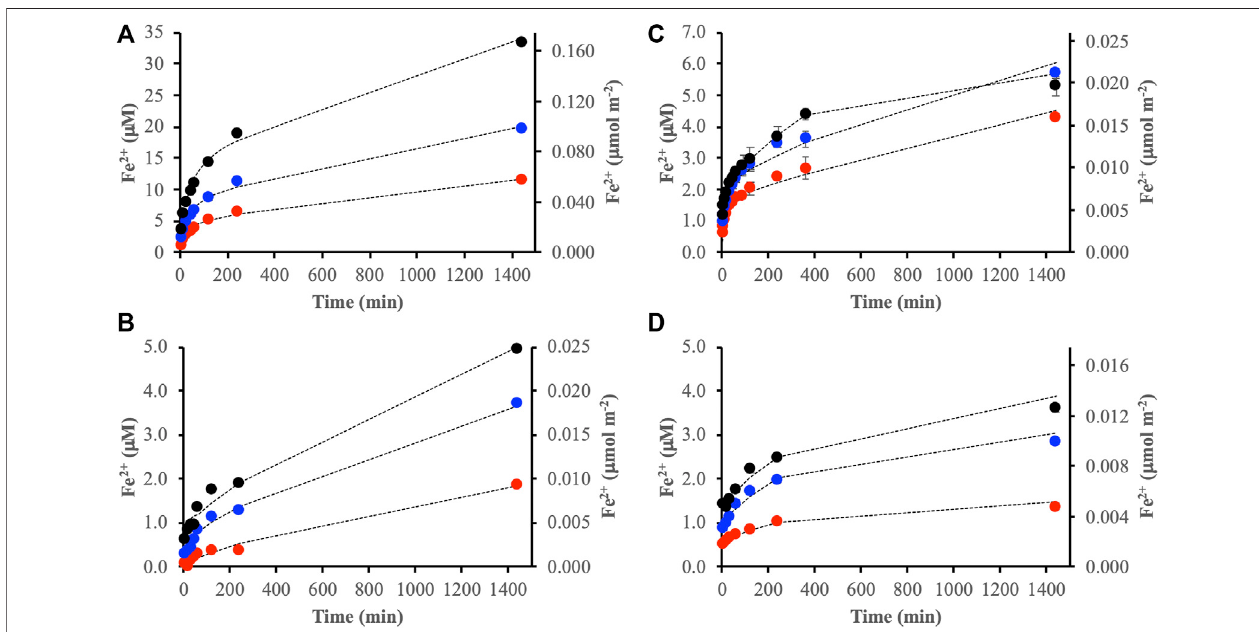
FIGURE 2 | Fe 2+ concentrations in solution from reductive dissolution by DOM mod-EtOAc of ferrihydrite (A) and goethite (C) and by DOM mod-H2O of ferrihydrite (B) and goethite (D) . The experiments were performed at TOC concentrations of 4.0 (red circles), 8.0 (blue circles) and 12.0 μ mol m − 2 (black circles). The dotted lines representthebest fi tof Eq.2 tothedata;the corresponding rateconstantsarereported in Table 1 .Thedatapoints represent the averageoftriplicate experiments, and thestandarddeviationsinFe 2+ concentrationsareinmostcasessmallerthanthesizeofthesymbols.Foraversionofthis fi guresshowingthe fi rst250 minonlysee Supplementay Figure